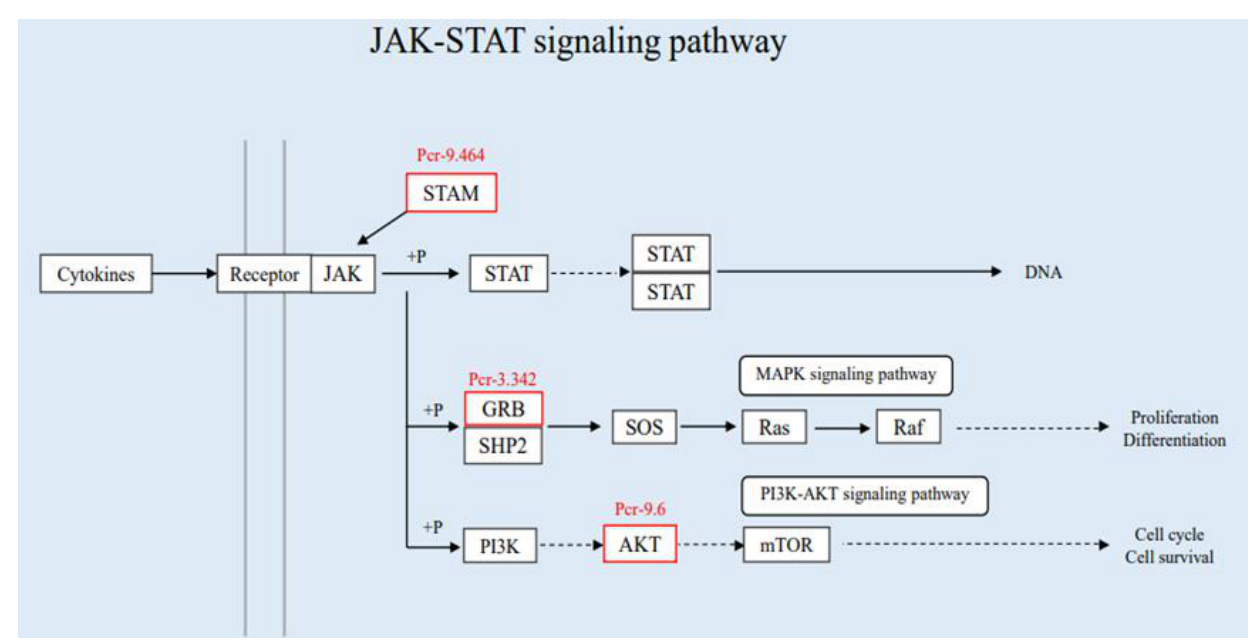
Figure 7. DEPs involved in the JAK-STAT signaling pathway. The two vertical gray lines on the left represent the cell membrane, the solid line is the activation effect, and the dotted line is the indirect effect.